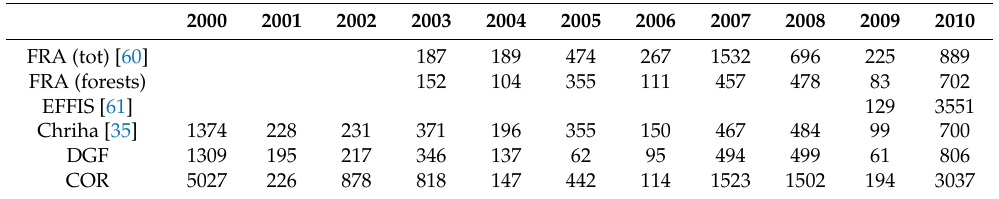
Table 3. Yearly burned area (in ha), for the period 2000–2010 in Tunisia from different sources compared to our historical synthesis on official statistics (DGF) and corrected values